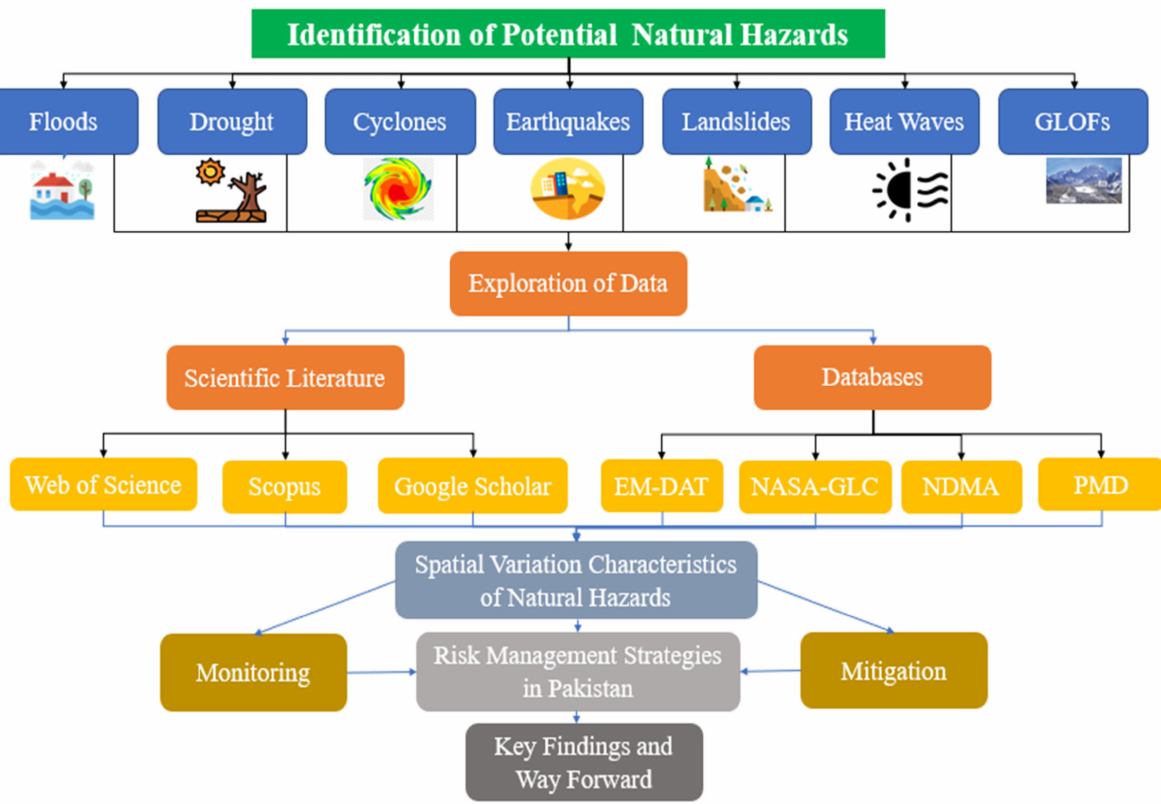
Figure 2. Methodology